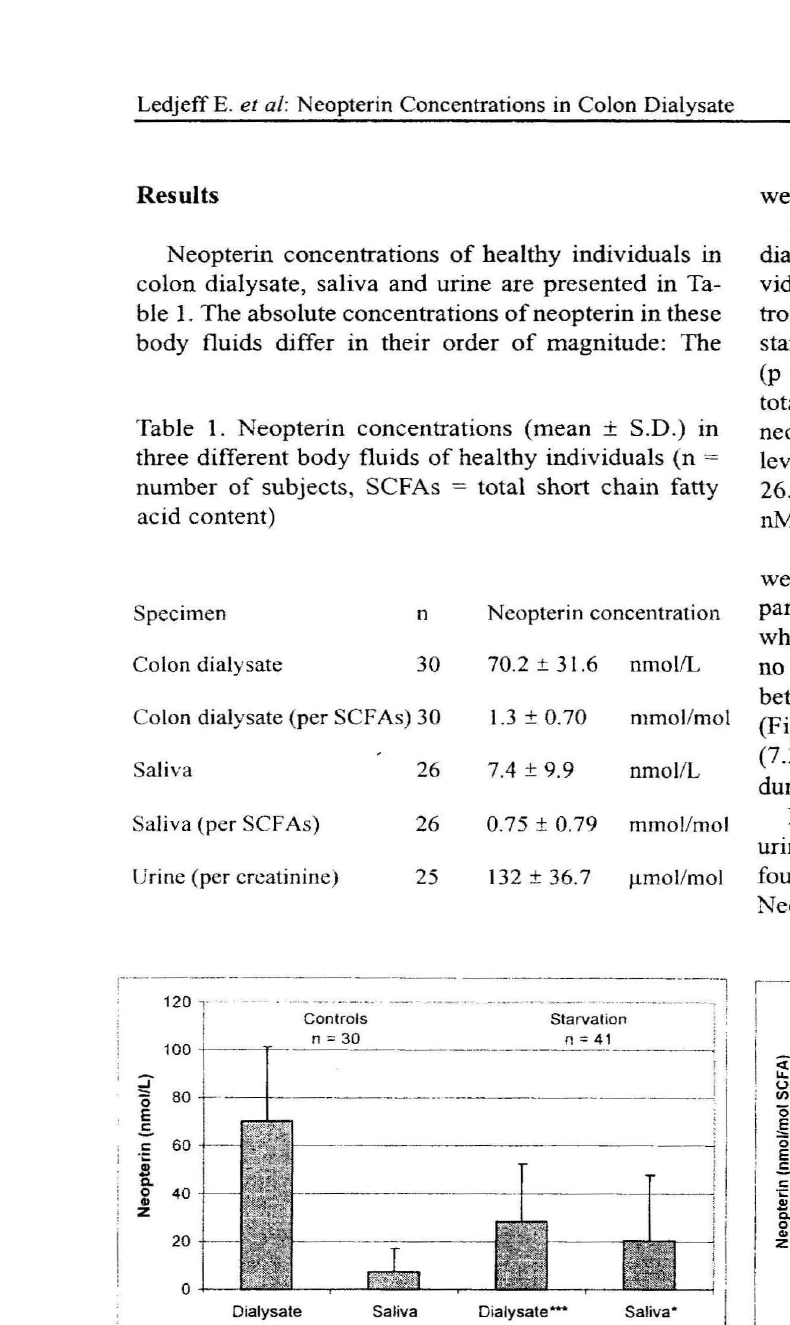
Figure 2. Concentrations of neopterin related to short chain fatty acids (SCFAs) concentrations (mean ± S.D.) in colon dialysates and salivas of healthy indi viduals and of healthy individuals during a starvation diet (*** p < 0.001 when compared with controls) were 1.12 ± 1.28 mM (mean ± S.D., p < 0.01 or 7.52 ± 6.20 mmollmol CFAs, p < 0.001, urinary neopterin concentrations were 200.5 ± 67.72 Jlmol/mol creati nine, p < 0.01. (Fig.